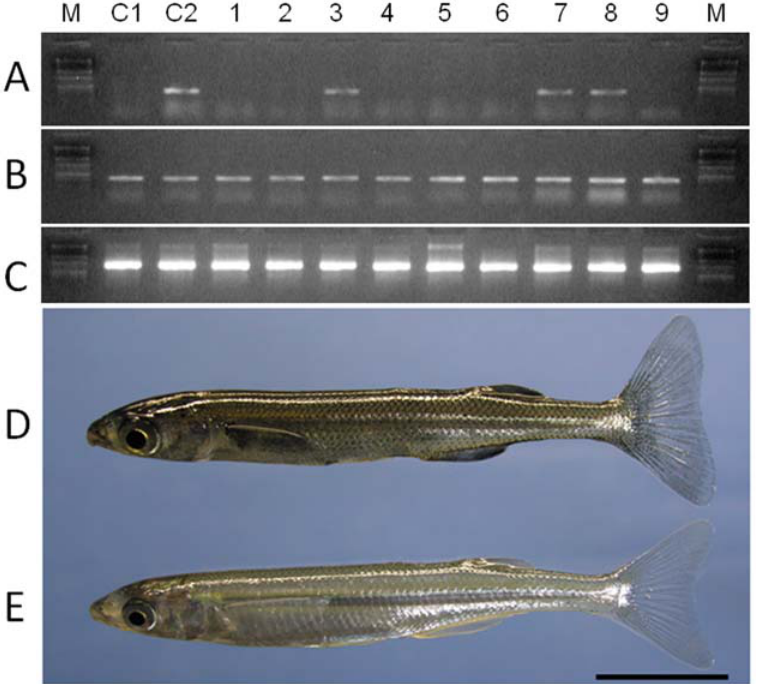
Figure 4. PCR analysis of 9 individual offspring from the cross between a surrogate O.hatcheri father ( # 2) and an O.bonariensis mother. The primers used were an O. hatcheri -specific sequence (A), an O. bonariensis -specific sequence (B) and b -actin (C) as a template control. Control lanes include a pure O. bonariensis (C1) and an artificially produced hybrid between an O. hatcheri male and an O. bonariensis female (C2). Individuals shown in lanes 3, 7, and 8 are hybrids of the two species (D) and those shown in lanes 1, 2, 4–6, and 9 are pure O. bonariensis (E). Scale bar indicates 1 cm (D and E).